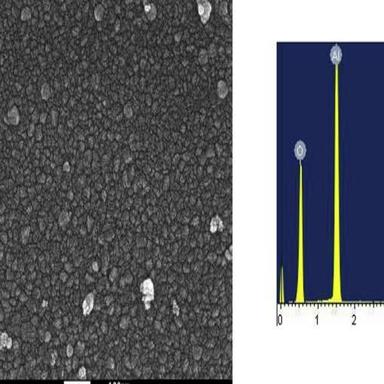
(A) SEM image of mesoporous alumina. (B) EDS spectrum of mesoporous alumina.